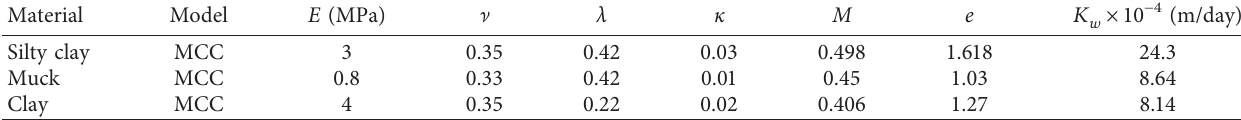
Table 1: ABAQUS finite element simulation material